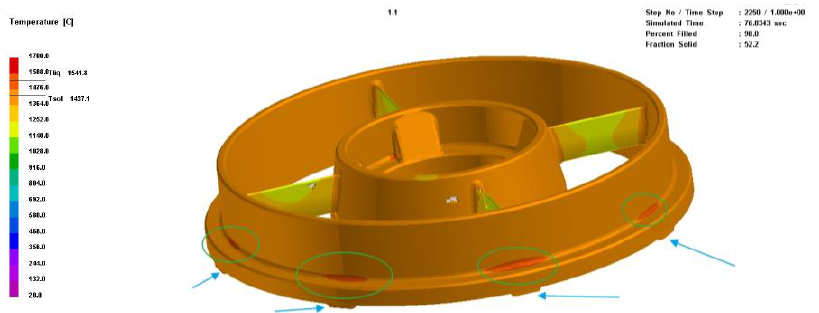
Figure 7. Temperature field in the superheated area of the water outlet near the root of the upper water outlet of thick and large flange (arrow points to the water outlet position, and the green circle is the superheated area).